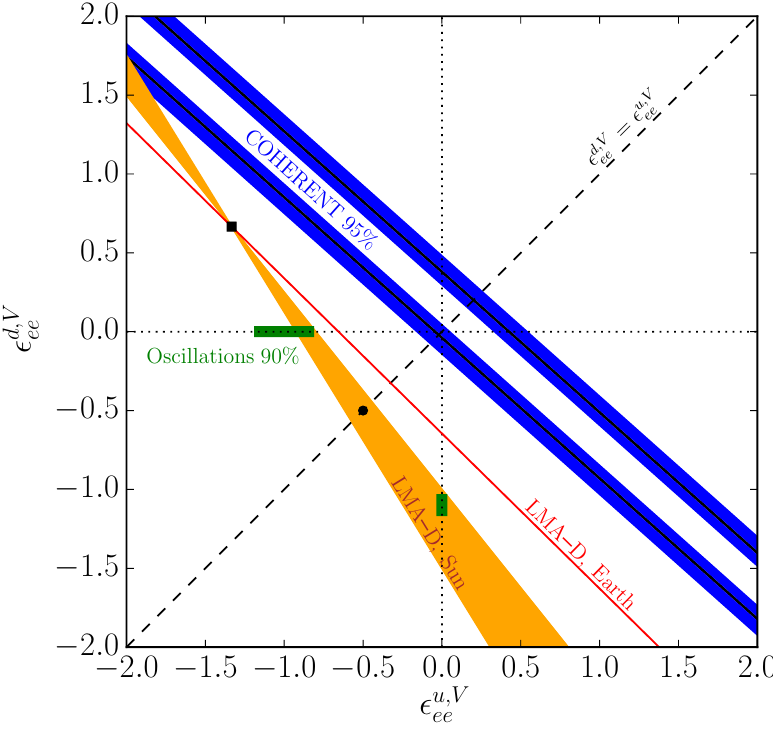
Figure 1 . The constraints on NSI in the (cid:15) d;V { (cid:15) u;V plane, setting all other NSI terms to zero. The ee ee red line and the orange region show (cid:15) ee = (cid:0) 2 respectively for Y n = 1 : 05 (the value in the Earth) and for Y n 2 [1 = 6 ; 1 = 2] (the values in the Sun). The intersection of these two lines shown by the square point is the point at which oscillations are exactly degenerate. The circle is the point on the (cid:15) d;V = (cid:15) u;V line we take for our canonical LMA-Dark value. The best (cid:12)ts values from COHERENT ee ee at (cid:31) 2 = 2 : 9 are the black lines with the 95% C.L. (2 d.o.f.) region shown in blue assuming x =